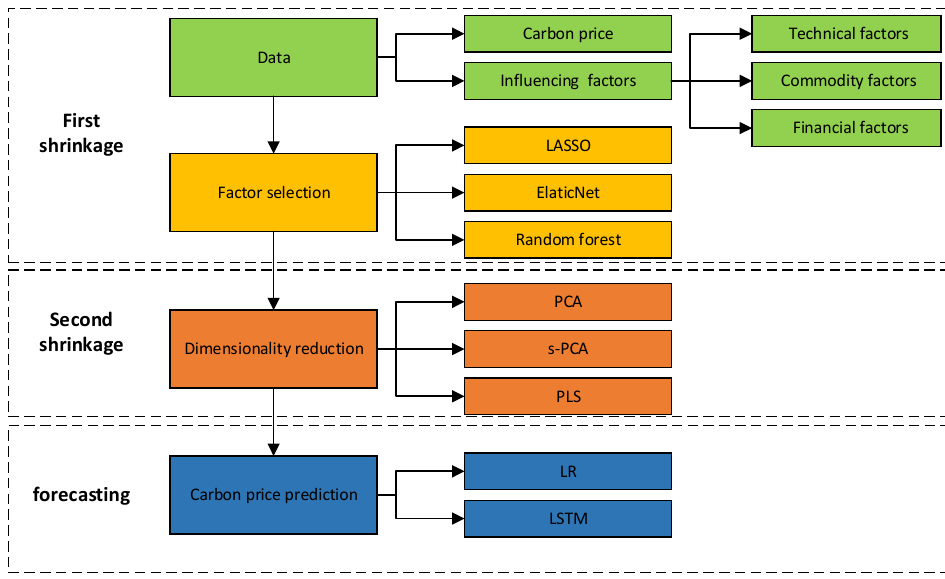
Figure 1. The framework of the proposed model.